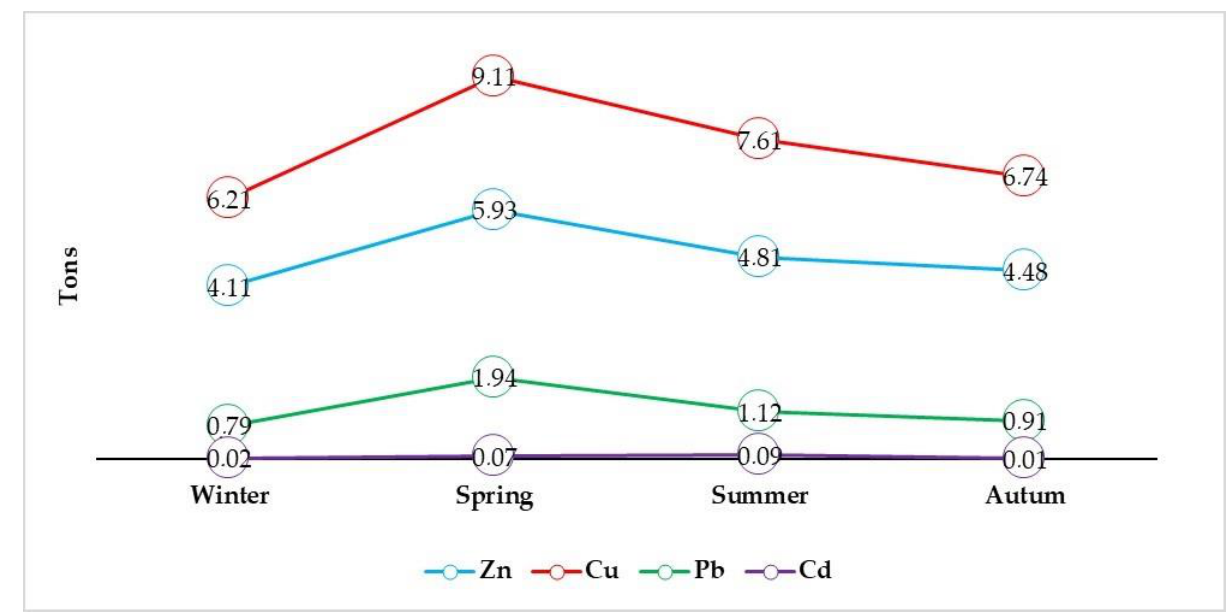
Figure 8. Seasonal inflow of heavy metals along the Ili River in the border cross-section Dobyn (2013) [54].